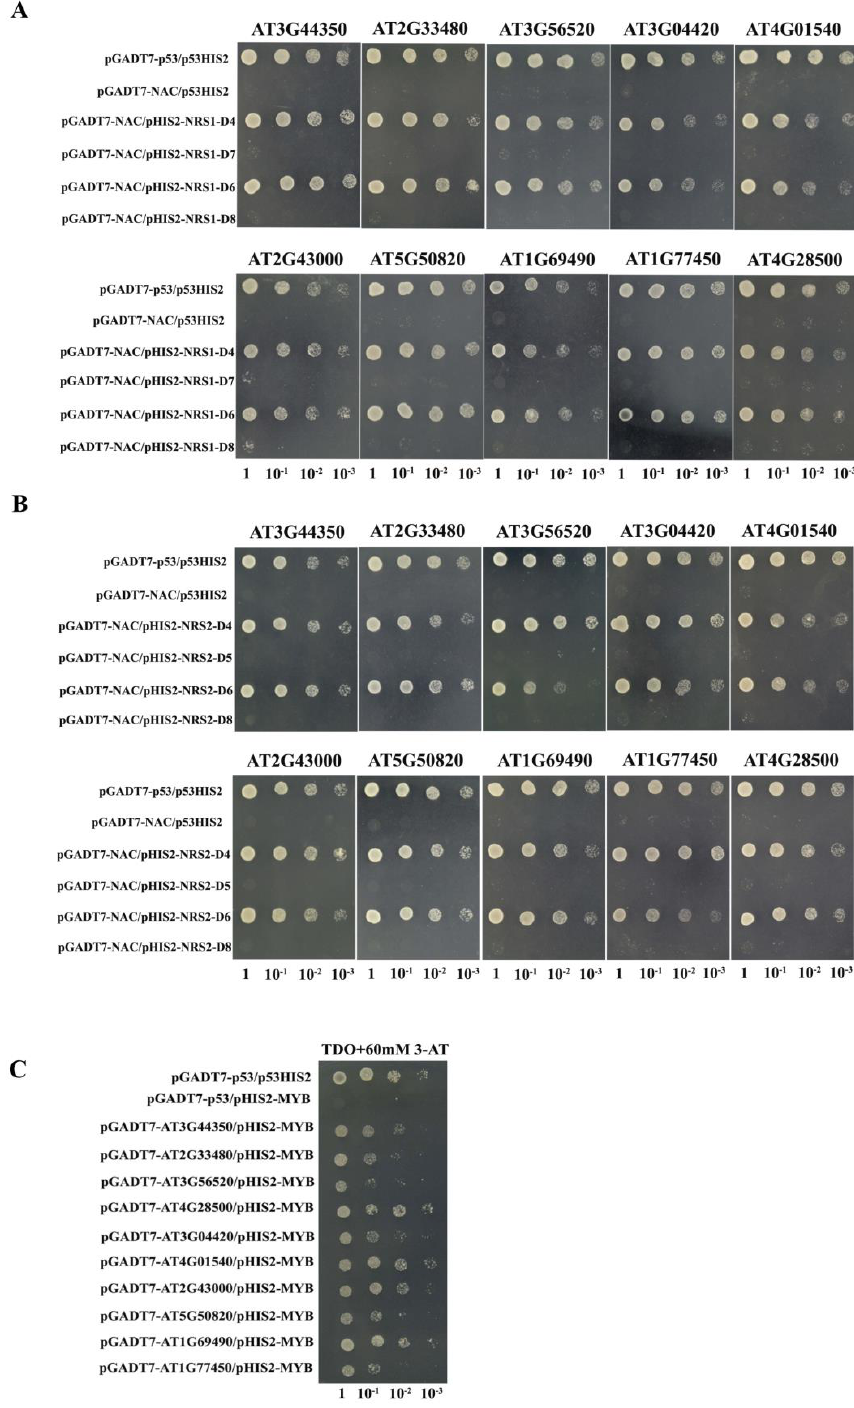
Figure 6. Bindings of NRS1, NRS2, and MybSt1 to other NACs from Arabidopsis . The bindings of ten NACs from different NAC subfamily to NRS1 ( A ), NRS2 ( B ), and MybSt1 ( C ). The ORFs of ten NACs were respectively fused with GAL4 AD in pGADT7-Rec2 as the effector constructs. pHIS2-NRS1-D4, -D7, -D6, -D8 or pHIS2-NRS2-D4, -D5, -D6, -D8: Three tandem copies of NRS1-D4, -D7, -D6, -D8, or NRS2-D4, -D5, -D6, -D8 (see Figure 1 for the sequence of these elements) were respectively cloned into the pHIS2 as the reporter constructs. Positive transformants were identified by spotting yeast cells with serial dilutions (1/1, 1/10, 1/100, 1/1000) onto medium of SD/-His/-Leu/-Trp with 60 mM 3-AT. Positive control: pGADT7-p53 interacting with p53HIS2; Negative control: pGADT7-ANAC074 interacting with